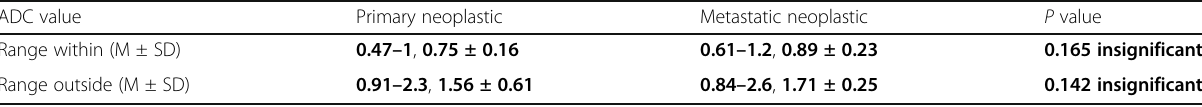
Table 6 DWI and ADC values within and outside tumor margins of the primary and metastatic neoplastic lesions ADC